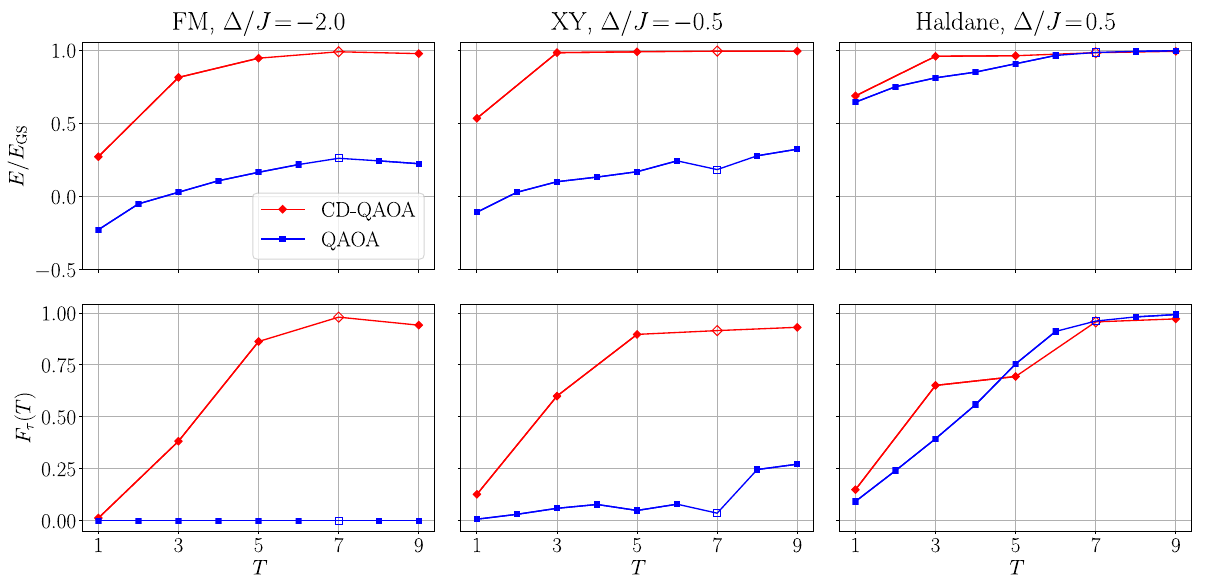
FIG. 19. Anisotropic Heisenberg spin-1 chain: energy minimization against protocol duration T — the corresponding energy (top row) and many-body fidelity (bottom row) for three ordered target states, corresponding to the ground state of the ferromagnetic (left, Δ =J ¼ − 2 . 0 ), XY (middle, Δ =J ¼ − 0 . 5 ), and Haldane (right, Δ =J ¼ 0 . 5 ) target states, respectively. The empty symbols mark the duration at which we show the evolution of the system in Fig. 20. The model parameters are the same as in Fig.